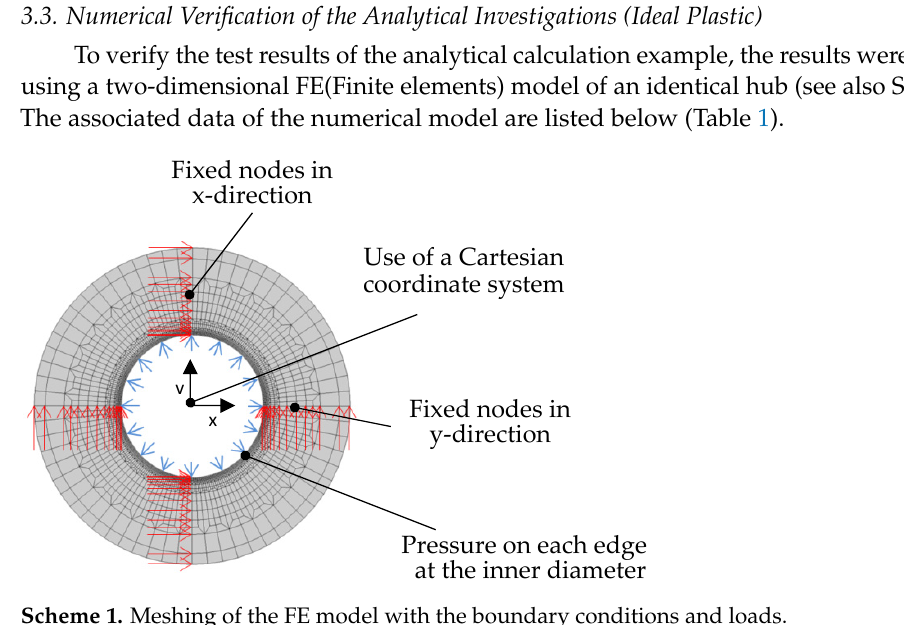
Scheme 1. Meshing of the FE model with the boundary conditions and loads. Table 1. Data of the numerical